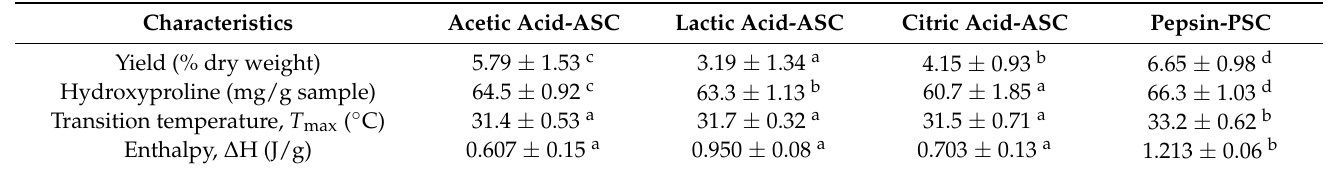
Table 1. Extraction yield, hydroxyproline content, denaturation temperature and enthalpy of extrac- tion collagen, ASC and PSC from the skin of purple-spotted